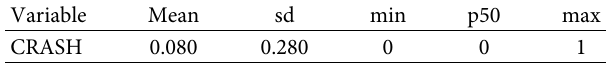
Table 7: Descriptive statistics of CRASH.